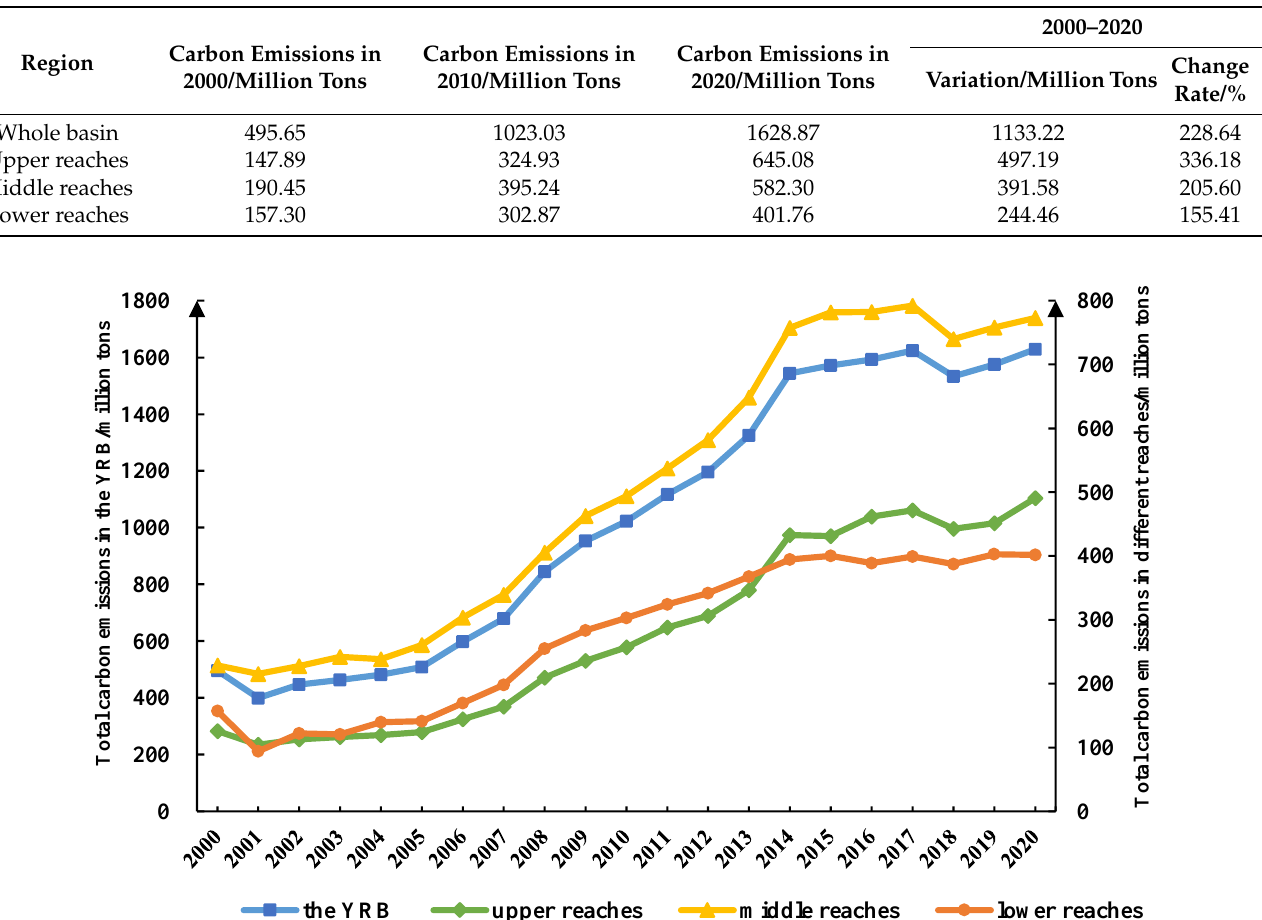
Table 4. Total carbon emissions and changes in the YRB and its reaches during 2000 – 2020.